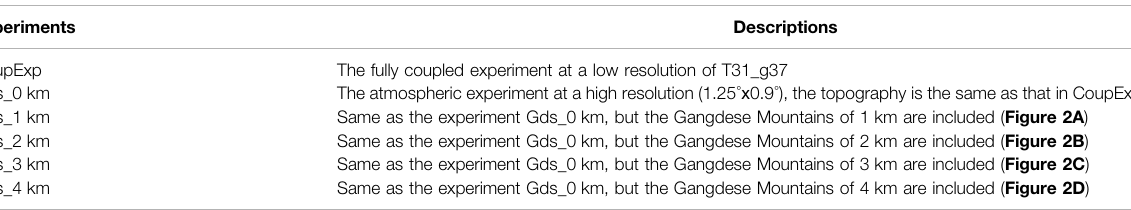
TABLE 1 | Description of the experimental setup.